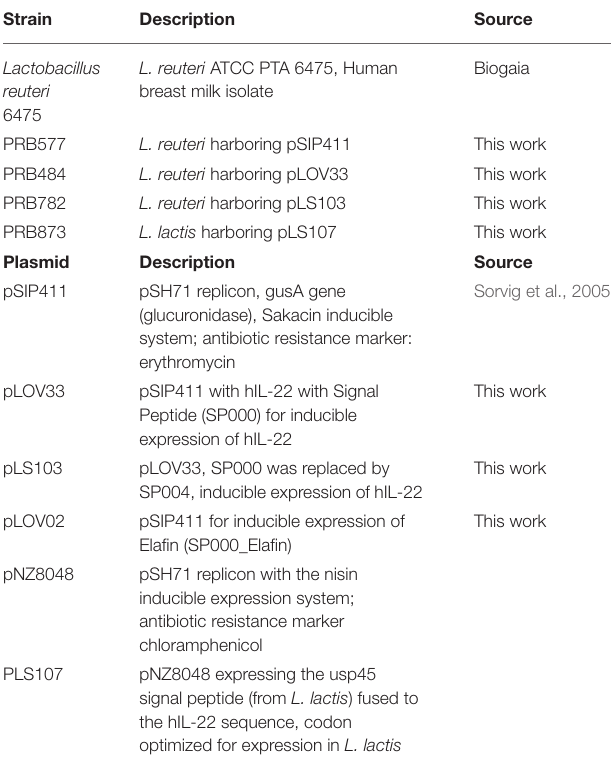
TABLE 1 | Primary strains and plasmids